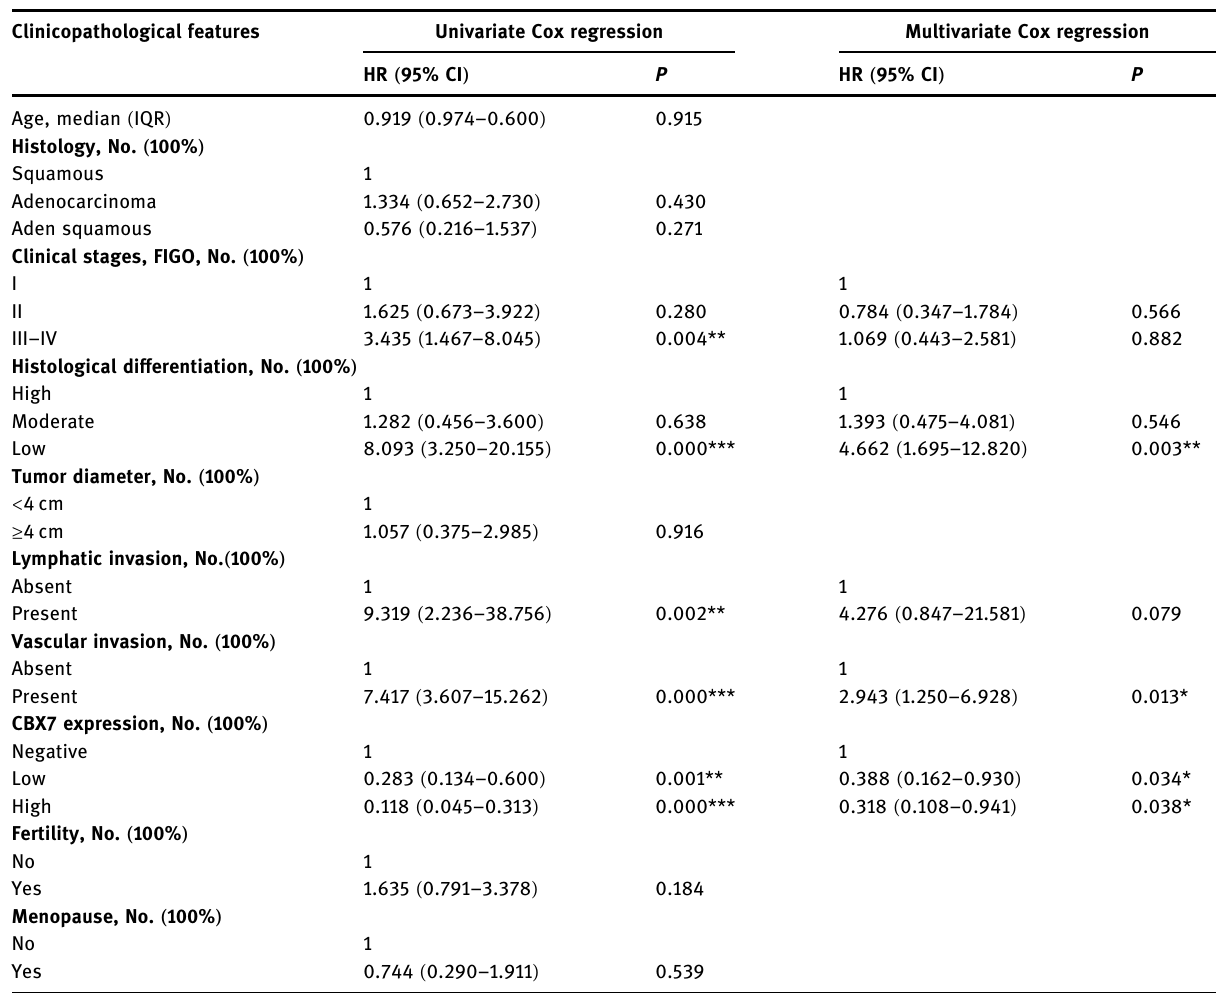
Table 2: Cox regression analysis of prognostic factors of